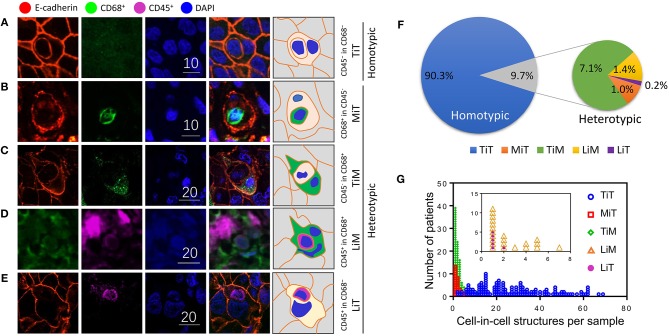
Subtype profiling of cell-in-cell structures in breast cancer. (A–E) Representative images for five CIC subtypes as indicated. Right panel of pictures demonstrate the schematic structure for each subtype of CICs. Scale bar: 10 or 20 μm; (F) composition analysis of five CIC subtypes; (G) distribution of five CIC subtypes across breast cancer tissues from different patients.